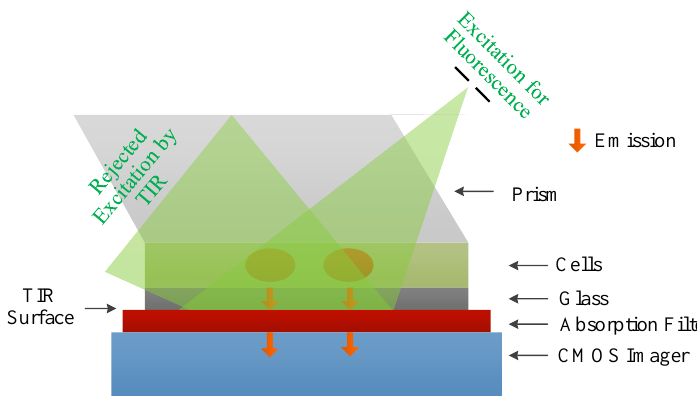
Figure 5. On-chip lens-free holographic fluorescent imaging platform with a wide field-of-view of 2.5 cm × 3.5 cm. Adapted from [24] with permission from The Royal Society of Chemistry.